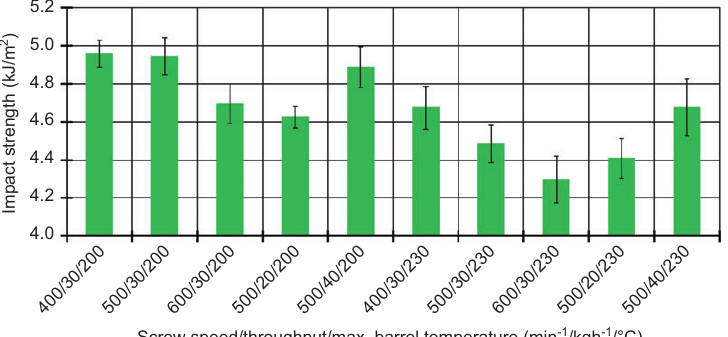
Figure 4 Notched impact strength for different process parameters at maximum barrel temperatures of 200 ° C and 230 ° C.